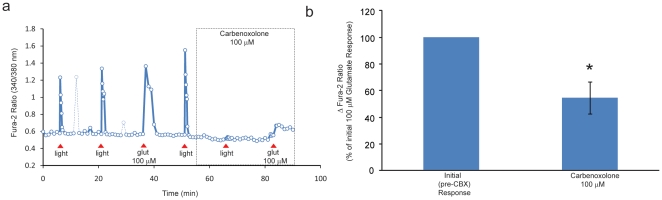
Carbenoxolone inhibition of glutamate-evoked Ca2+ responses in ipRGCs.(a) Carbenoxolone (CBX, 100 µM) completely blocked the light-evoked rise in [Ca2+]i and inhibited the glutamate-evoked elevation in [Ca2+]i (b) Summary (means ± SEM, normalized to the pretreatment responses) illustrating the carbenoxolone inhibition of glutamate-evoked rise in Ca2+ (following complete inhibition of the light-evoked Ca2+ response). * p<0.01, Student's t-test (n = 7)